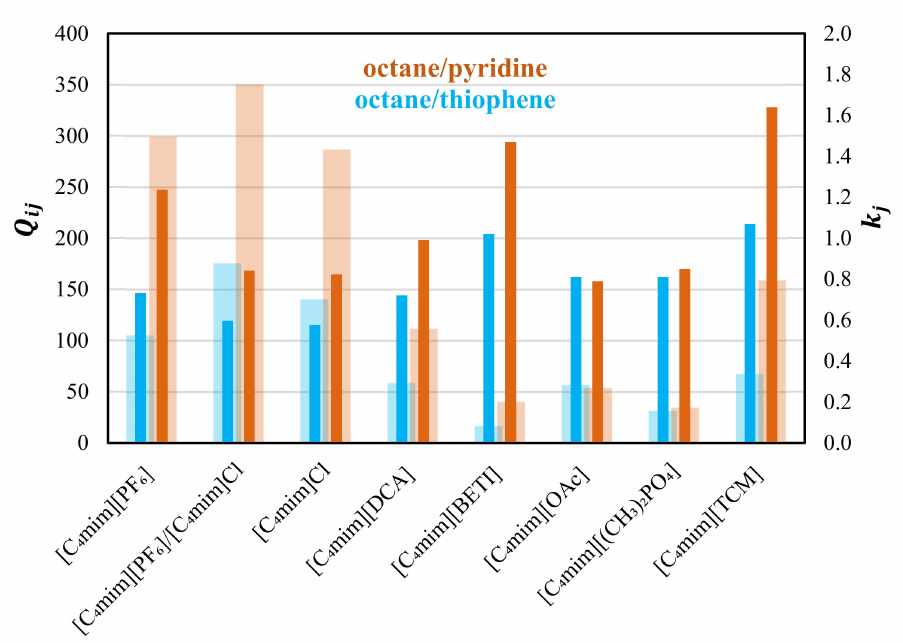
Figure 5. Comparison between the solvent performance index, Q ∞ pacities, k j , (dark colored bars) at infinite dilution for the separation of octane/thiophene (blue) and octane/pyridine (orange) at 333.2 K in [C 4 mim][PF 6 ], equimolar [C 4 mim][PF 6 ]/[C 4